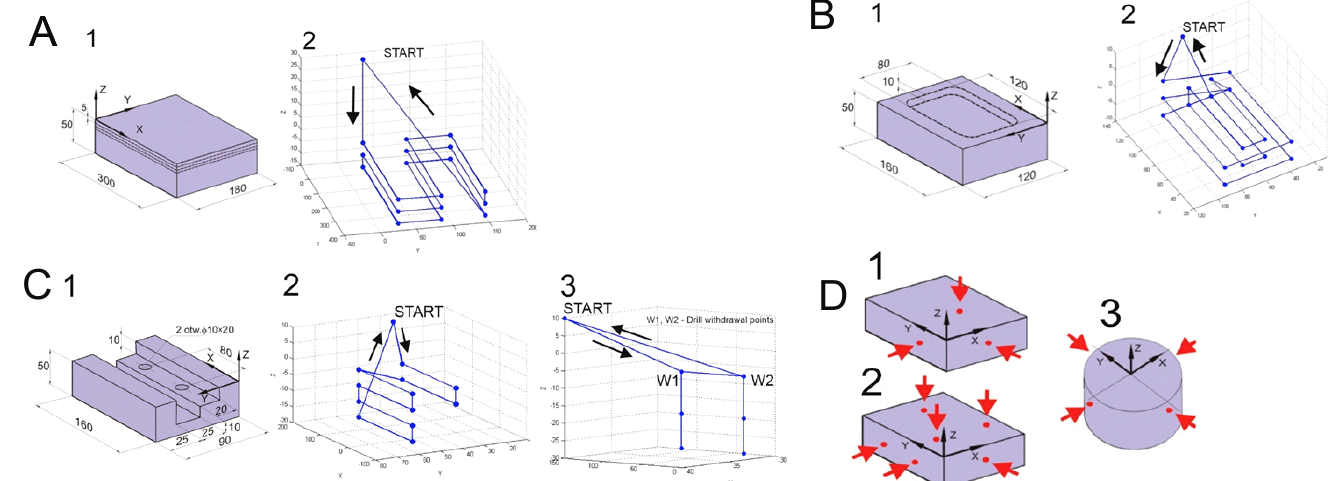
Figure 13. ( A ) Variant I of the study: 1—workpiece to be machined; 2—drawing of the designed tool path milling. ( B ) Variant II of the study: 1—workpiece to be machined; 2—drawing of the designed tool path milling. ( C ) Variant III of the study: 1—workpiece to be machined; 2—drawing of the designed tool path milling; 3—drawing of the designed tool path drilling. ( D ) Diagram of workpiece measurement operation: 1—measurement of workpiece position by 3 points 1/1/1 diagram—variant IV; 2—measurement of workpiece position by 6 points 3/2/1 diagram—variant V; 3—measurement of cylinder diameter by 4 points—variant VI.